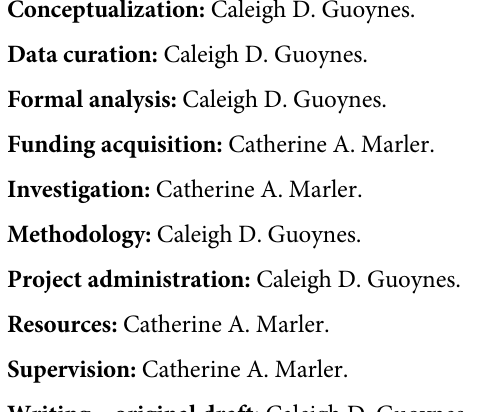
S1 Table. Means and SEMs of behaviors measured.